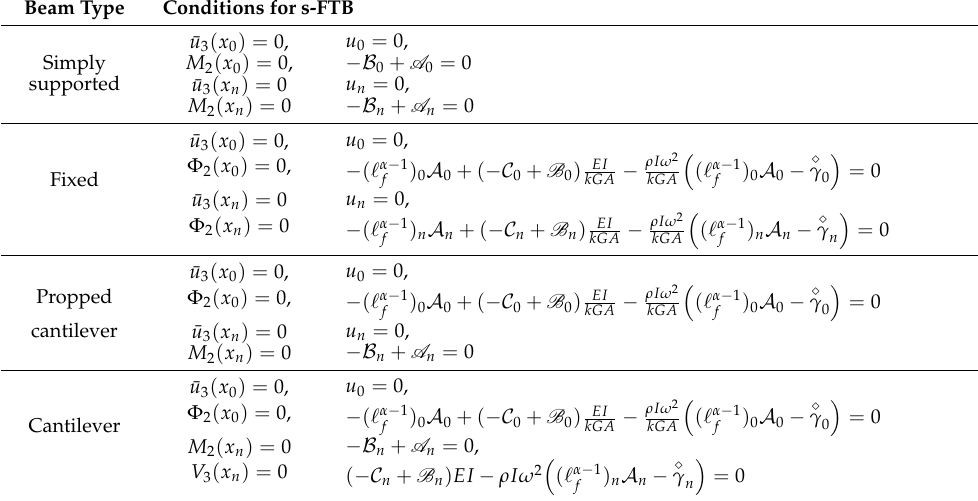
Table 3. Boundary conditions for s-FTB applied for the selected static scheme (see also Equations (18), (A12) ÷ (A14), and Figure